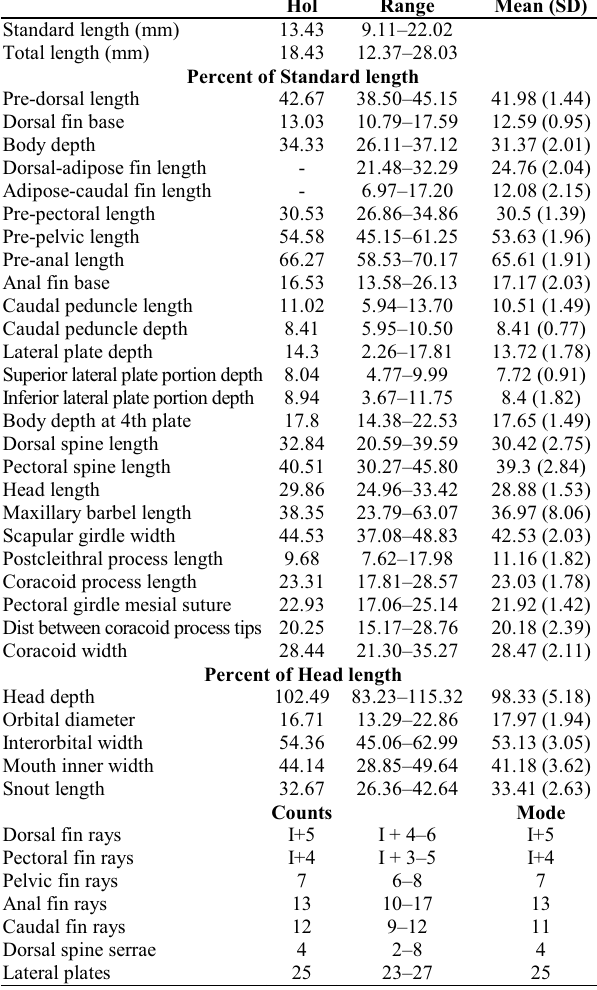
Table 2. Descriptive morphometrics and counts of Physopyxis ananas (N = 148). SD = Standard deviation. Hol =